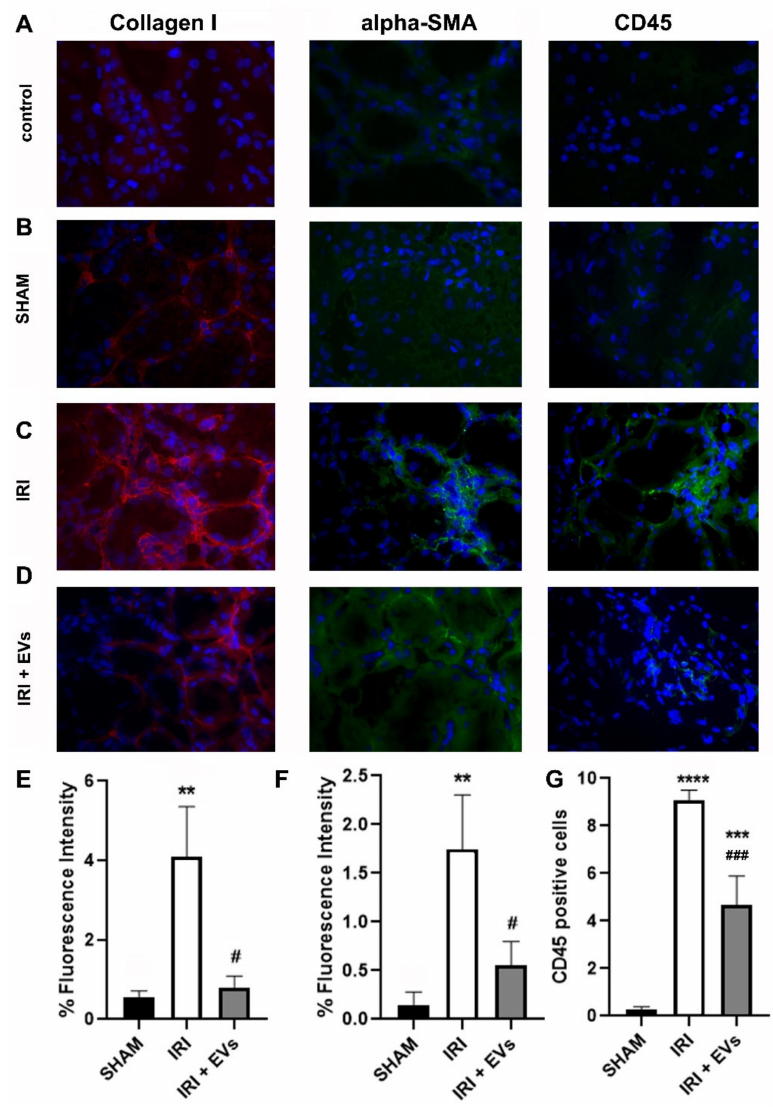
Figure 4. The effect of HLSC-EVs on fibrosis and inflammation in a renal IRI murine model. ( A – D ) Kidney cryo-sections from control (SHAM) mice ( B ), IRI-mice treated with the vehicle ( C ), or with EVs ( D ) were stained for collagen I, alpha-SMA, and CD45. Sections that were stained with secondary antibodies only served as control ( A ). ( E – G ) Histograms depicting the fluorescence intensity of collagen I ( E ) and alpha-SMA ( F ), and the quantification of CD45-positive cells ( G ) in renal cryo-sections from the different experimental groups. The data represent the mean ± SD of the fluorescence intensity or cells positive per high power field (HPF) that was measured from 10 images that were taken at random from four mice/groups (original magnification: 400 × ). Statistical analysis was performed using ANOVA with Tukey’s multicomparison test. ** p < 0.005 IRI-mice vs SHAM and # p < 0.005 IRI + EVs mice vs IRI-mice for % of fluorescence intensity for Collagen I-staining; ** p < 0.005 IRI-mice vs SHAM and # p < 0.02 IRI + EVs mice vs IRI-mice for % of fluorescence intensity for alpha-SMA-staining; **** p < 0.0001 IRI-mice vs SHAM, *** p < 0.001 IRI +EVs mice vs SHAM and ### p < 0.001 IRI +EVs mice vs IRI-mice for CD45+ cell enumeration. As the development of fibrosis re-activates the genes that are involved in EMT [39], we evaluated the expression levels of genes that were involved in EMT process, such as SNAI1 and TWIST1 , in the renal tissue of IRI-mice. Moreover, we evaluated the gene expression levels of vimentin ( VIM ), a marker of mesenchymal cells, and of zonula occludens 1 ( ZO1 ), an adhesion receptor that is expressed by the epithelial cells